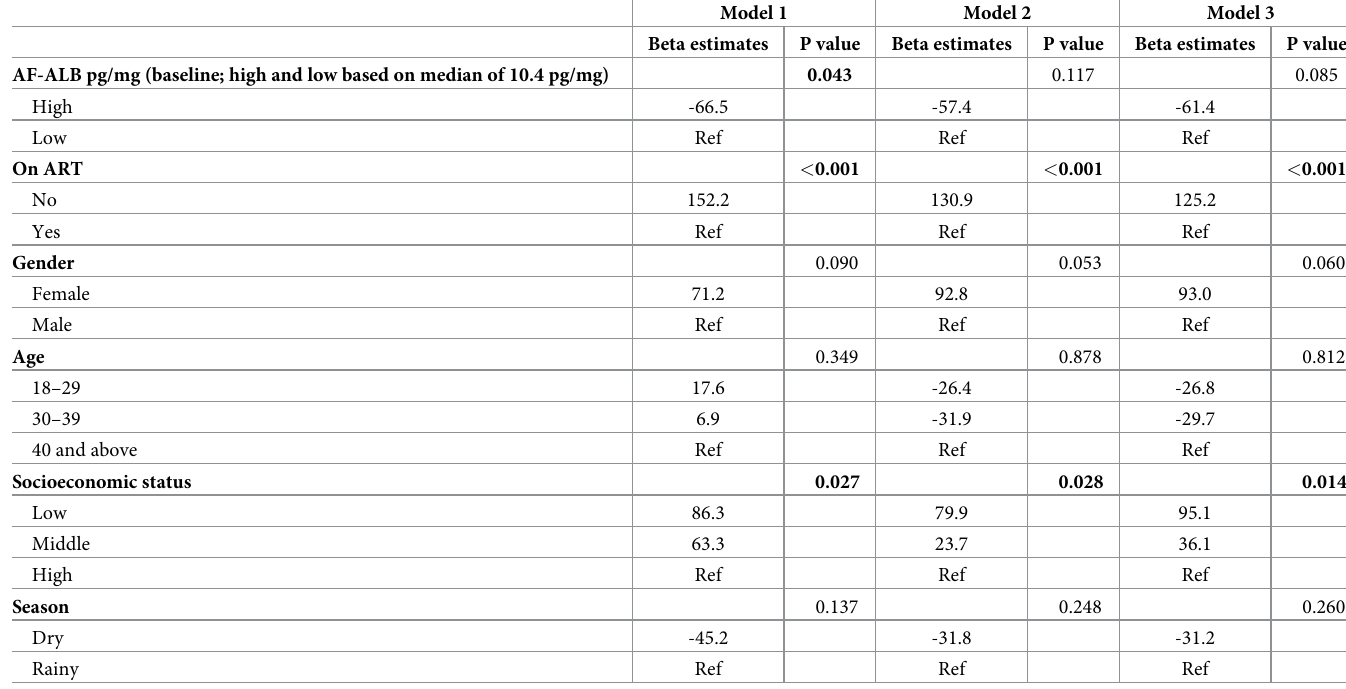
Table 3. Multivariable adjusted models of mean CD4 estimates over the study